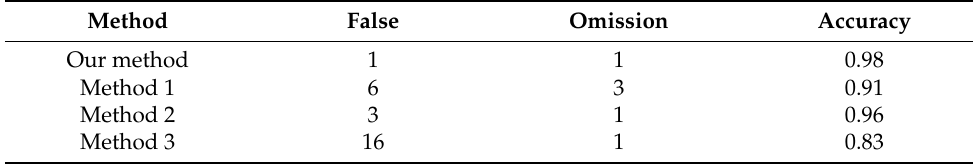
Table 5. Comparison with other target detection